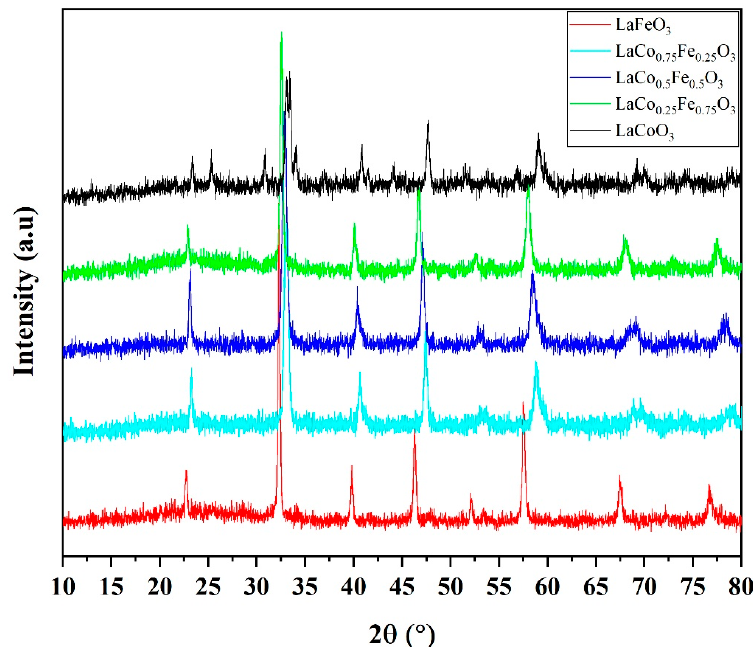
Figure 10. XRD patterns of the post-reaction